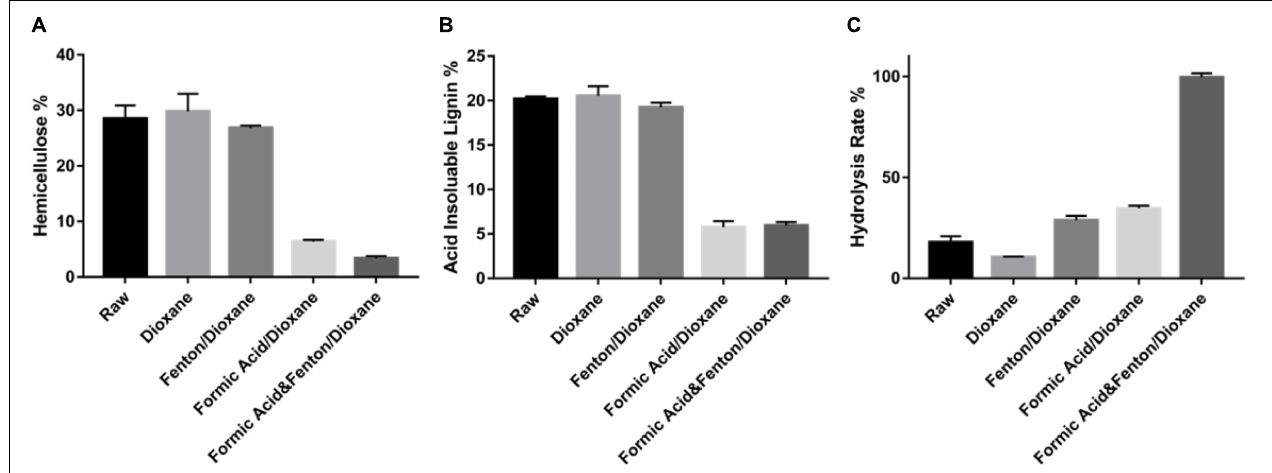
FIGURE 1 | Removal of lignin and hemicellulose after different pretreatment methods. (A) hemicellulose; (B) acid insoluble lignin; (C) hydrolysis performance by different pretreatment method. The error bars in the hemicellulose and hemicellulose composition analysis represent the standard deviation from three replicates. The paired t test showed a significant difference between F 2 O and Raw with a p -value < 0.05 in the composition of hemicellulose, acid insoluble lignin, and hydrolysis